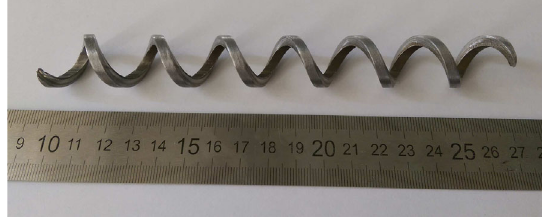
FIG. 4. Steel helix with square cross section used for experimental measurements of induced transverse magnetic